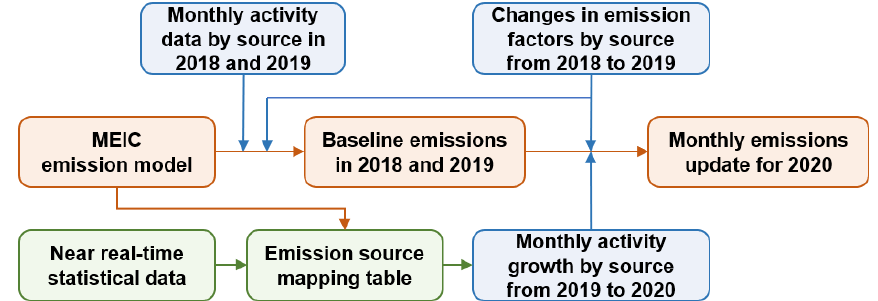
Figure 1. Methodological framework developed to estimate the monthly emissions in